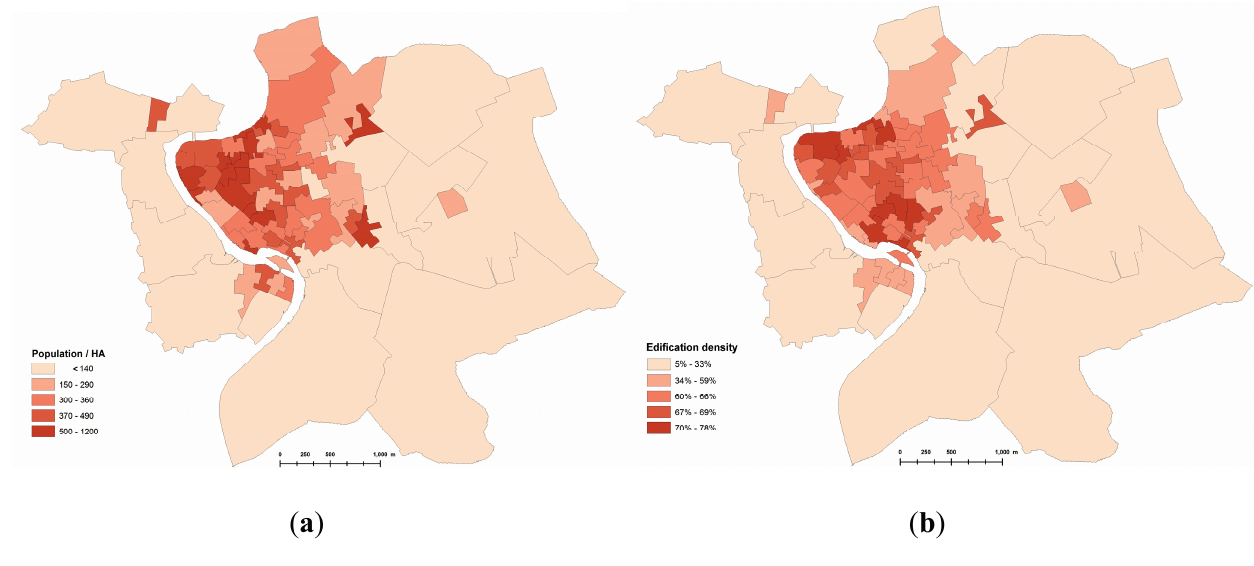
Figure 12. ( a ) Population density and ( b ) rate of soil edification in the Rioni (districts) of Rome in the 18th century.